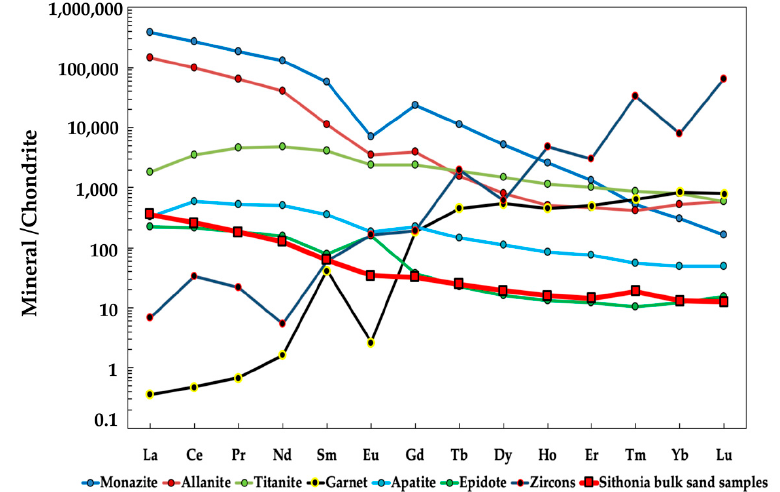
Figure 12. Chondrite-normalized patterns of the main mineral constituents of heavy mineral sands from the Sithonia coast [63].